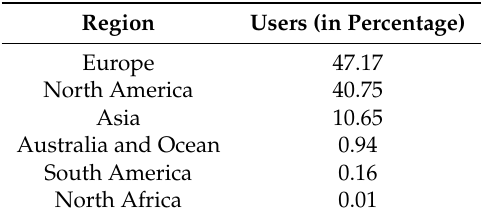
Table 4. This table illustrates the diversity of users across the world by nationality and region. These users’ data contain information about their connections and